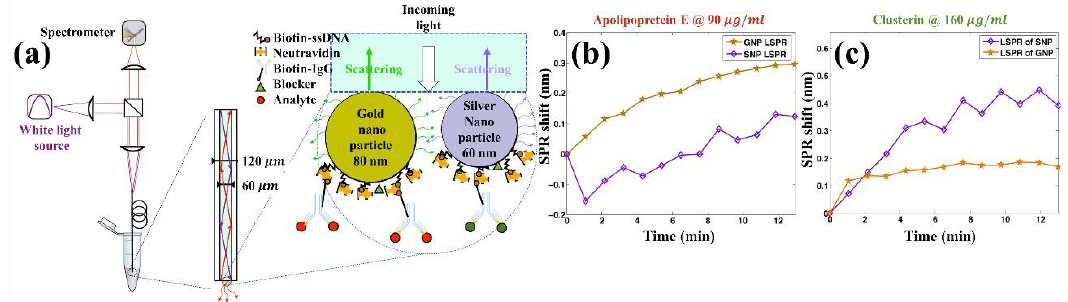
Figure 12. ( a ) Schematic of a fiber-optic LSPR biological sensor that integrates two different types of nanoparticles (gold nanoparticles with a diameter of 80 nm and silver nanoparticles with a diameter of 60 nm) for two different gastric cancer biomarkers. ( b ) The localized surface plasmon resonance (LSPR) was found to shift when the fiber-optic sensor was exposed to a solution of apolipoprotein E with a concentration of 90 μg/mL. Apolipoprotein E was detectable by gold nanoparticles in the fiber-optic sensor with a linear response. ( c ) The LSPR was found to shift when the fiber-optic sensor was exposed to a solution of clusterin with a concentration of 160 μg/mL. Clusterin was measurable by silver nanoparticles in the fiber-optic sensor. The figure in Sciacca et al. [104] is reprinted with permission from ACS Publications, Copyright (2020) American Chemical Society.